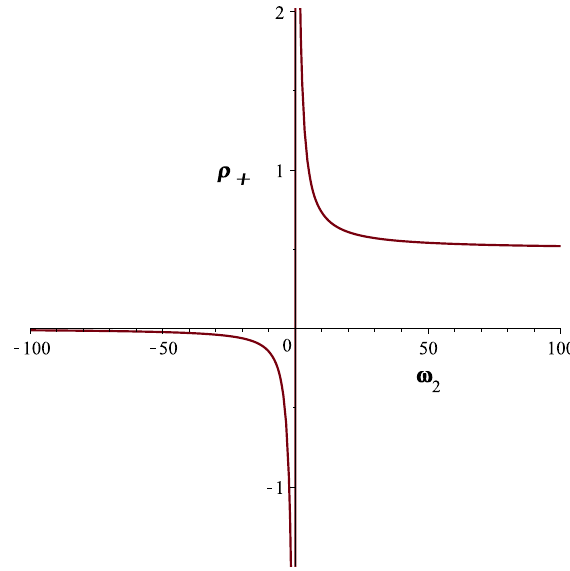
Fig. 11 The plot depicts the function ρ + (ω 2 ) as a function of ω 2 . It is clear that ρ + is not in the possible range 0 ≤ ρ ≤ 1 acceptable. See the tex for details